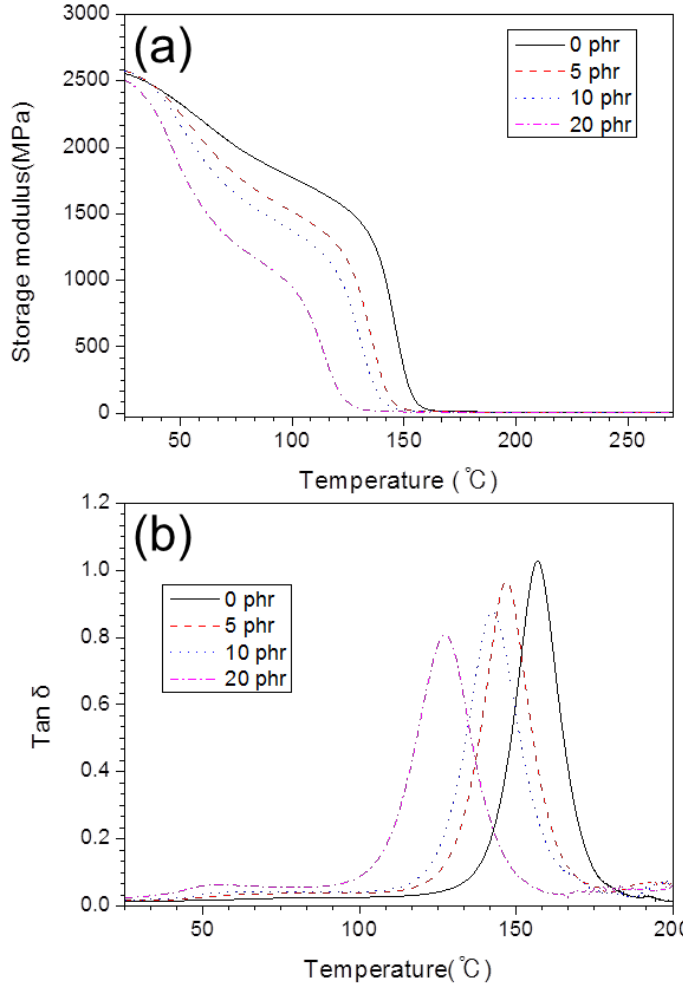
Figure 7. DMA graphs of epoxy compositions ( a ) storage modulus and ( b ) tan δ .